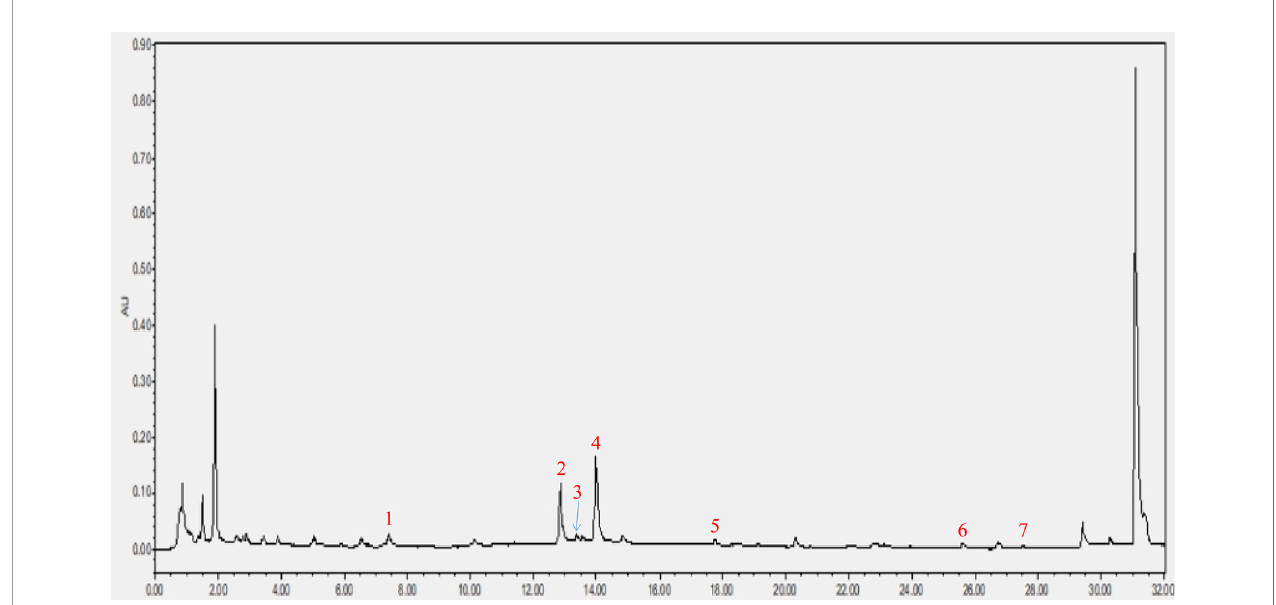
FIGURE 2 | HPLC analysis of CRP extract. (1) narigin-4 ’ -O-glucoside, (2) narirutin, (3) naringin, (4) hesperidin, (5) poncirin, (6) nobiletin and (7)